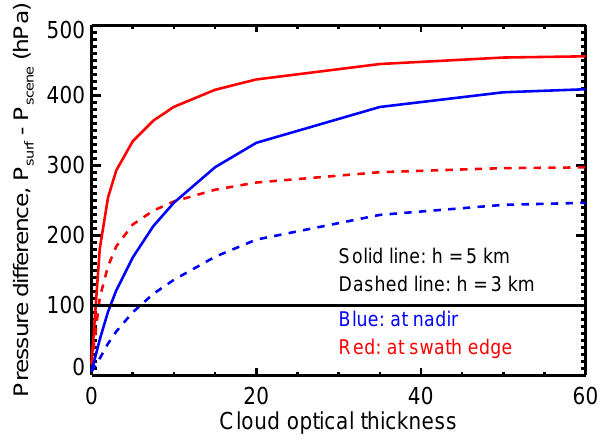
Fig. 2. Cloud pressure difference, P surf − P scene , from simulated ice cloud data for surface albedo 0.7 and geometry of OMI scan line 300.